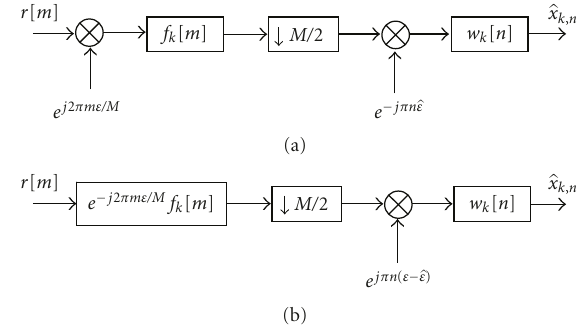
Figure 3: Subchannel receiver signal model in the presence of CFO, with CFO compensation and subchannel equalization. (a) Basic model. (b) Equivalent